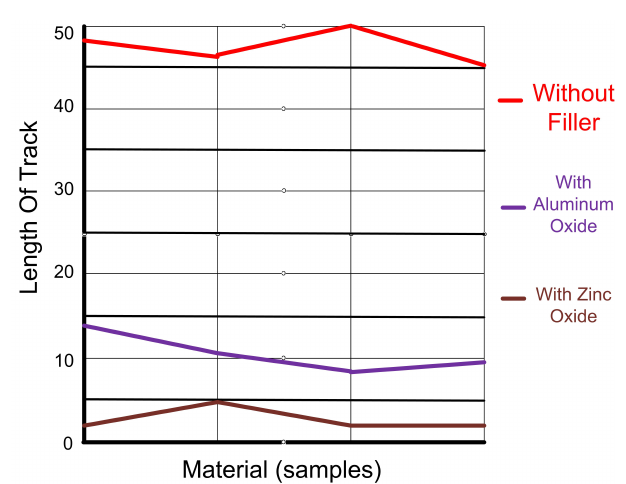
Figure 4. Inclined plane test bed